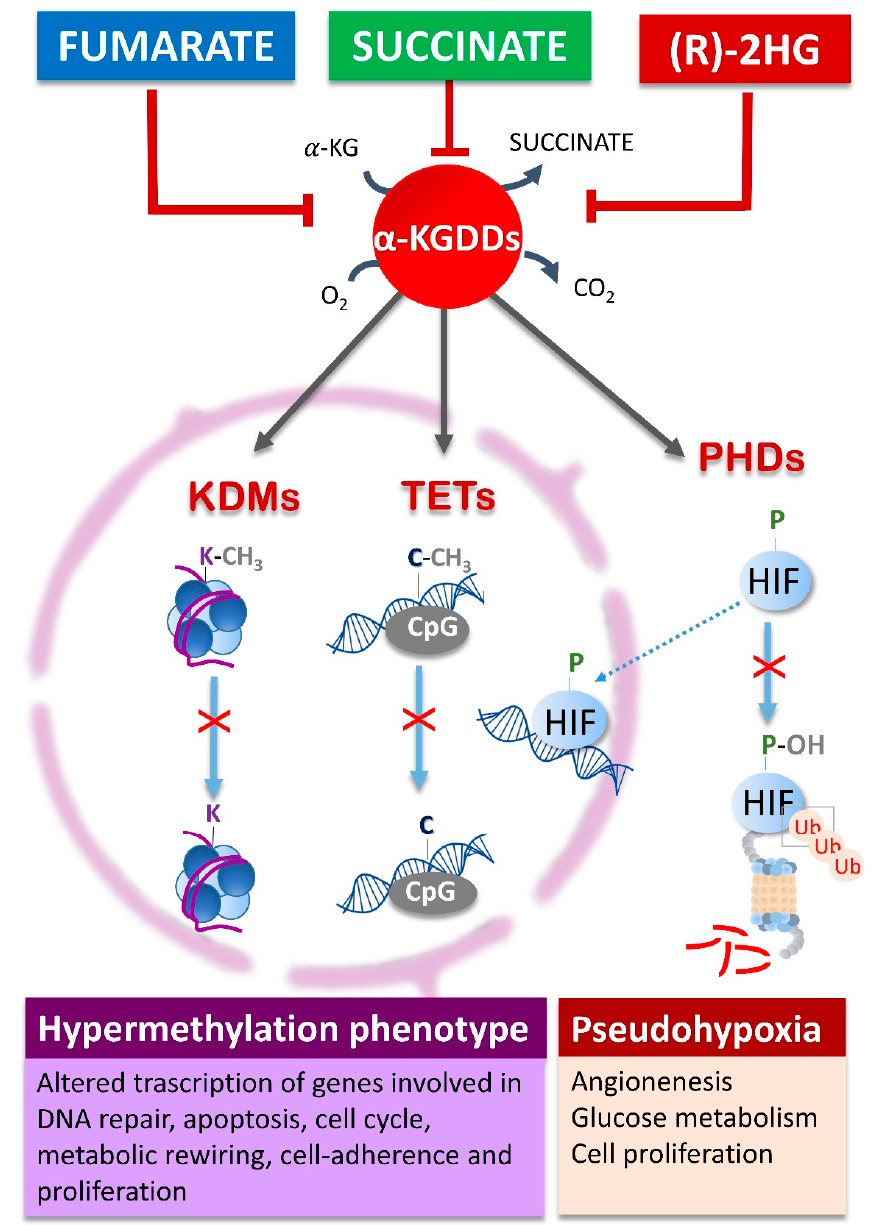
Figure 2. Oncometabolites epigenetic and pseudohypoxia effects. Oncometabolites act as competitive inhibitors of α KG-dependent dioxygenases ( α KGDDs) such as the KDMs and TETs families responsible for the modulation of chromatin by demethylation of histones and DNA CpG islands, respectively. The inhibition of PHDs blocks the HIF proline hydroxylation for the ubiquitin-proteasome degradation leading to HIF stabilization and activation of the hypoxia signalling pathway establishing a pseudo- hypoxic phenotype. KDMs, lysine histone demethylases; TETs, ten-eleven translocation; K, lysine; C, cytosine; P, proline; PHDs, prolyl hydroxylases; HIF, hypoxia ‐ inducible factor; Ub, ubiquitin.